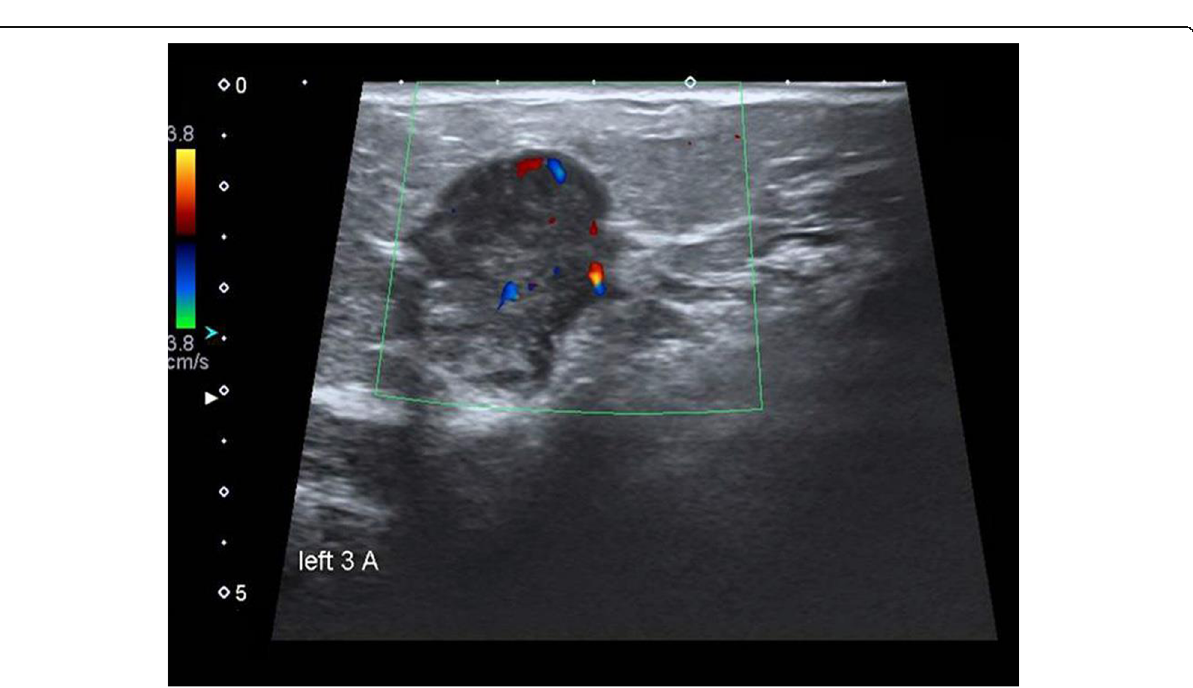
Fig. 4 B mode ultrasound revealed hypoechoic irregular shaped mass with speculated margin, antiparallel orientation, and no posterior features. On CCDI, it shows internal vascularity, assessed as BIRADS 5. Pathology: invasive ductal carcinoma (grade I). Biological markers: ER positive, PR positive, HER/neu-2 negative, and Ki67